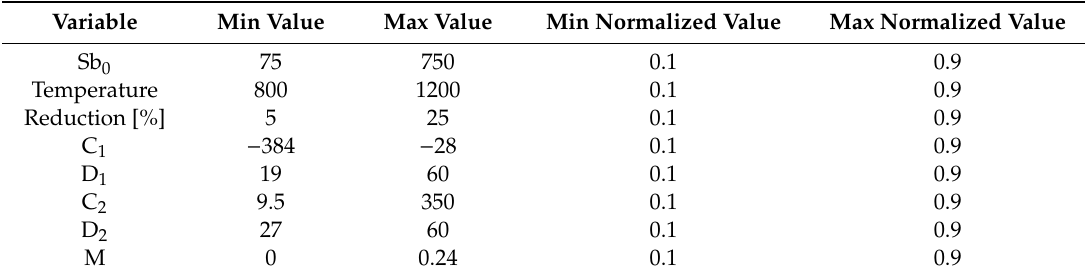
Table 2. Normalized values for artificial neural